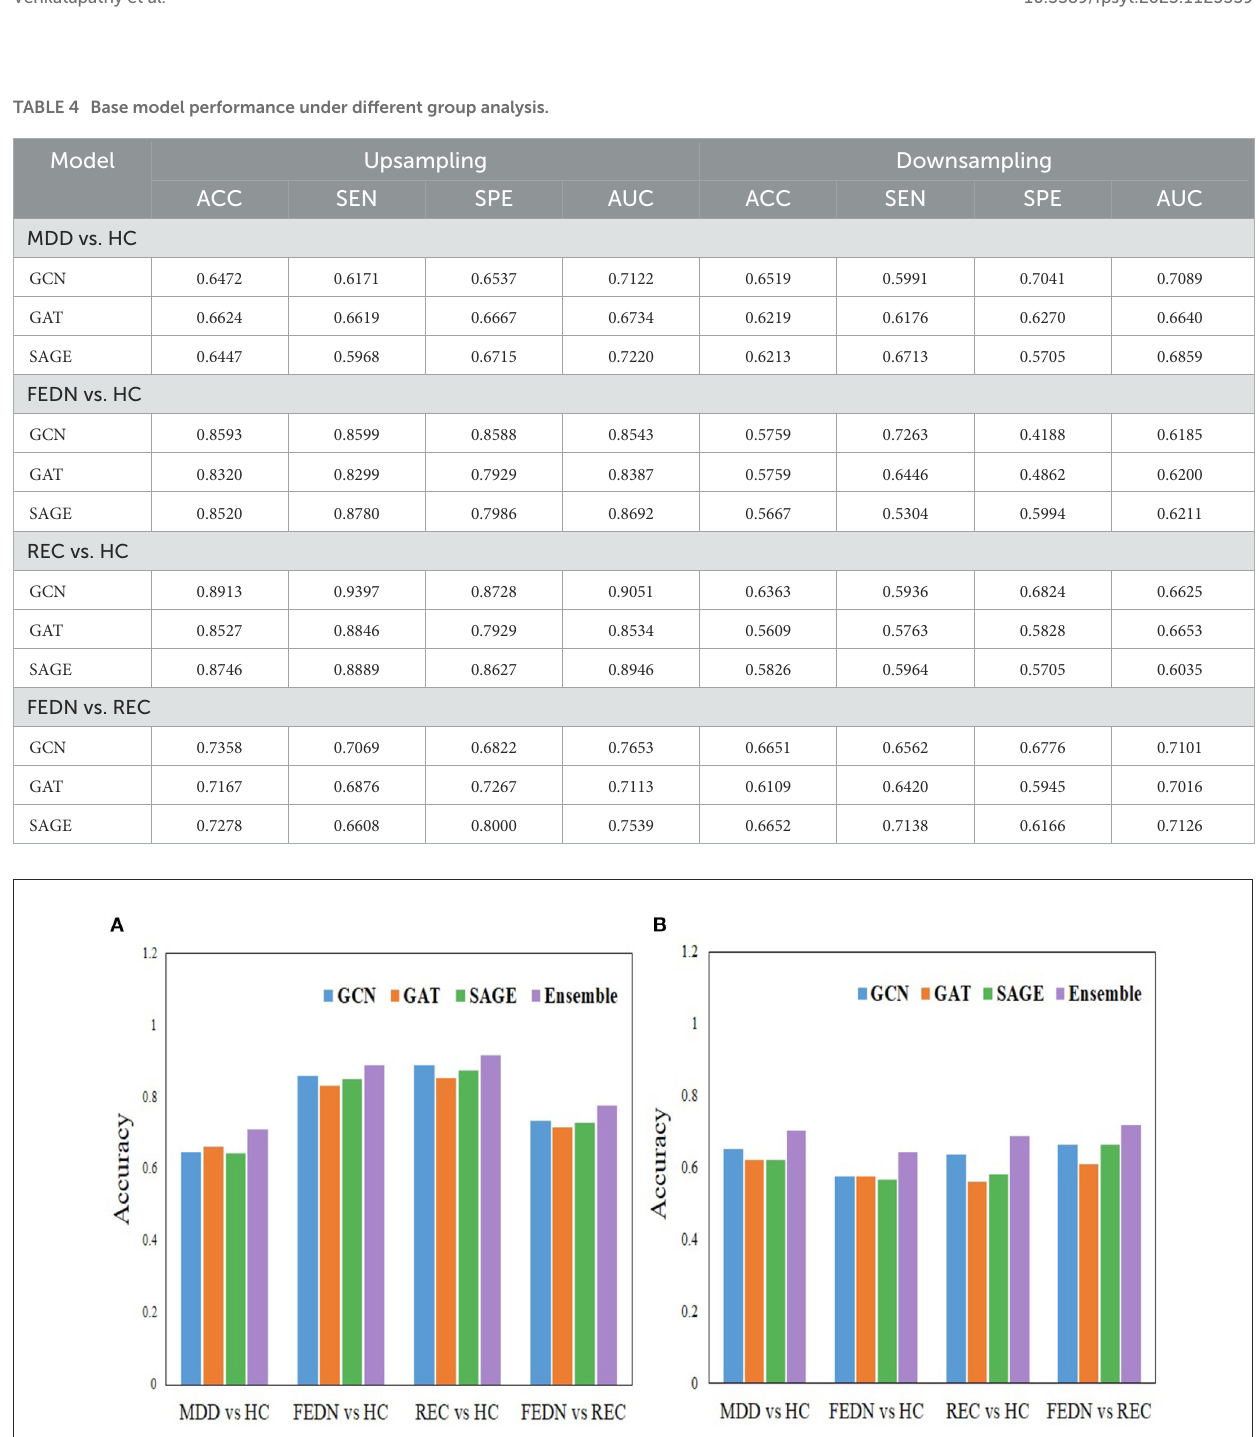
FIGURE6 Comparison analysis between the individual model and the ensemble model. (A) Upsampling and (B)